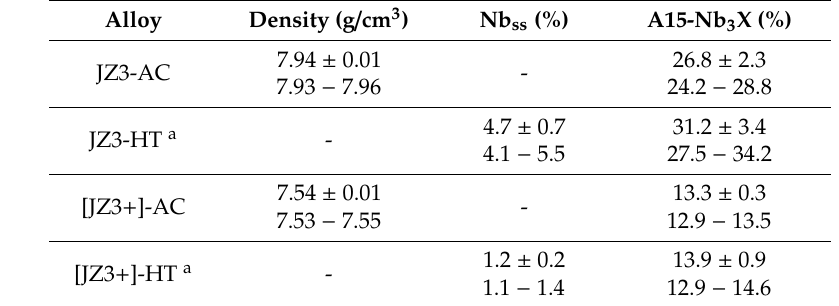
Table 1. Density of the as cast (AC) and % area of Nb ss and A15-Nb 3 X in the bulk of the AC and heat treated (HT) alloys JZ3 and JZ3 + .